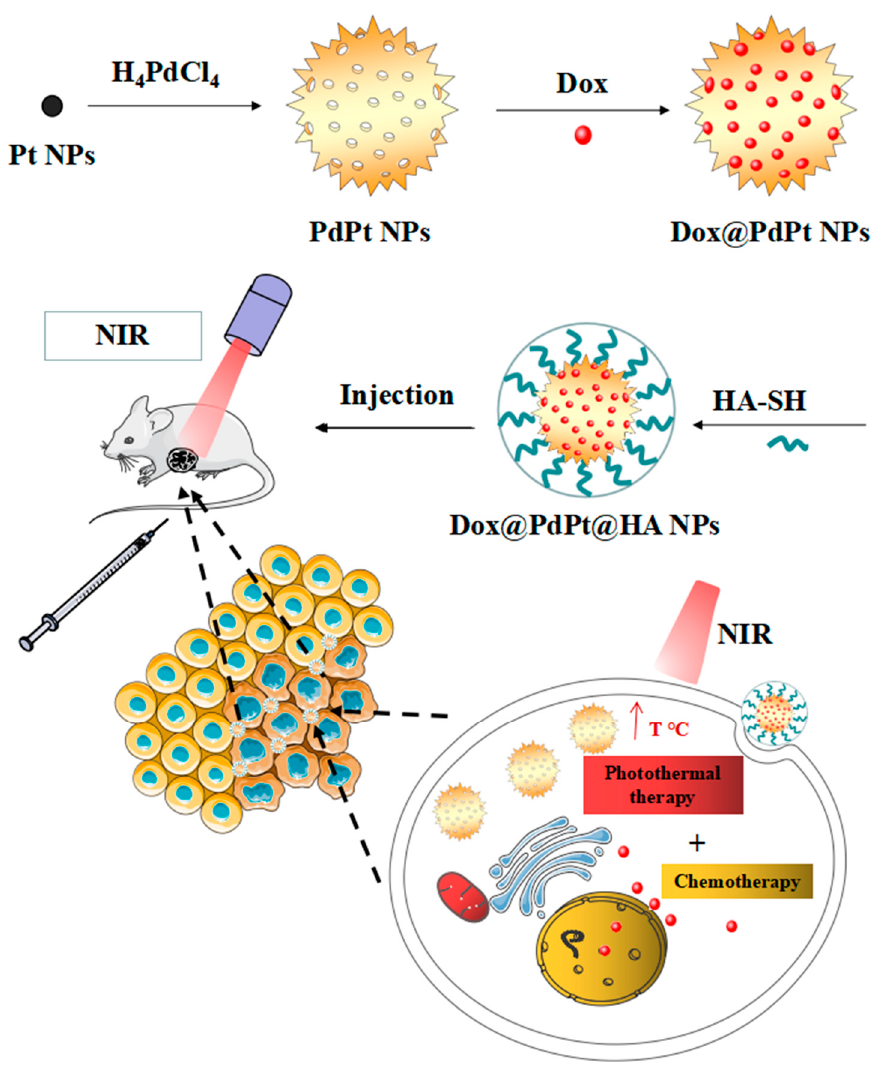
Figure 1. Schematic illustration of preparation of DOX@PdPt@HA nanoparticles (NPs) and near infrared (NIR) laser irradiation-induced hyperthermia triggered doxorubicin (DOX) release for